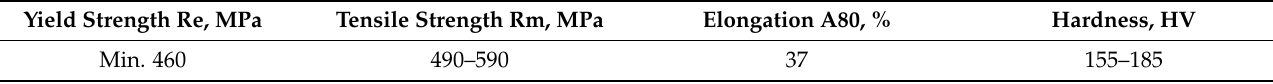
Table 2. Selected properties of DC04 steel in the tempered